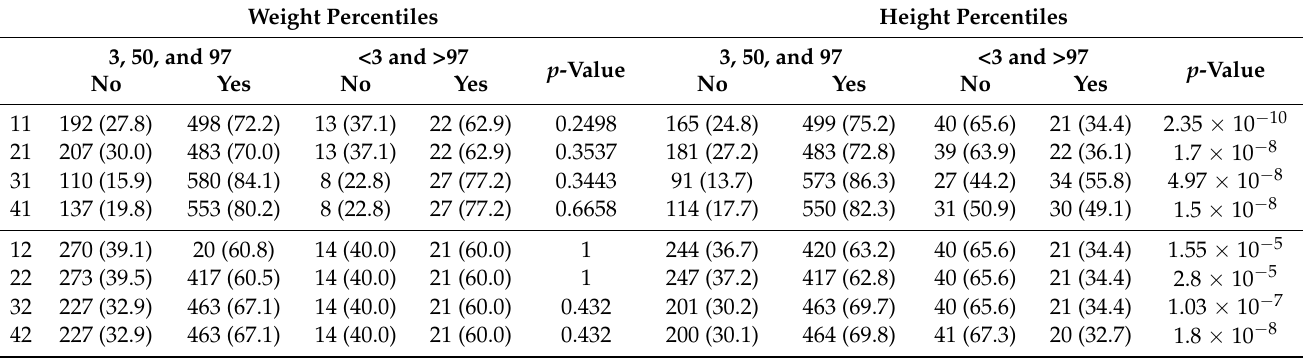
Table 3. Eruption of the incisor group and its relationship with weight and height percentile. Descrip- tive and comparative statistics: absolute and relative frequencies; contingency tables and Fisher’s exact test.